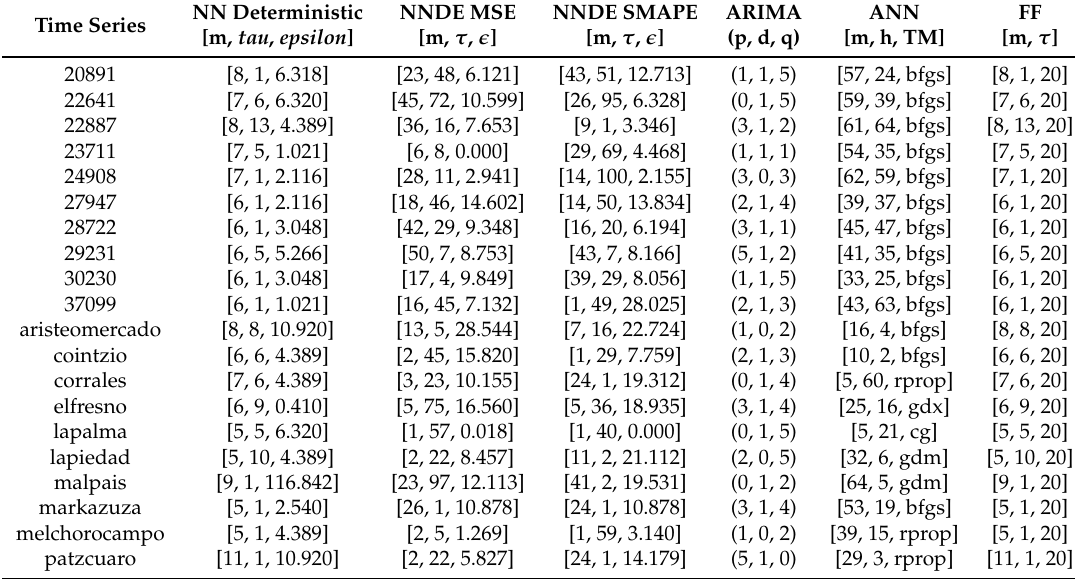
Table 2. Parameters of the forecasting techniques for